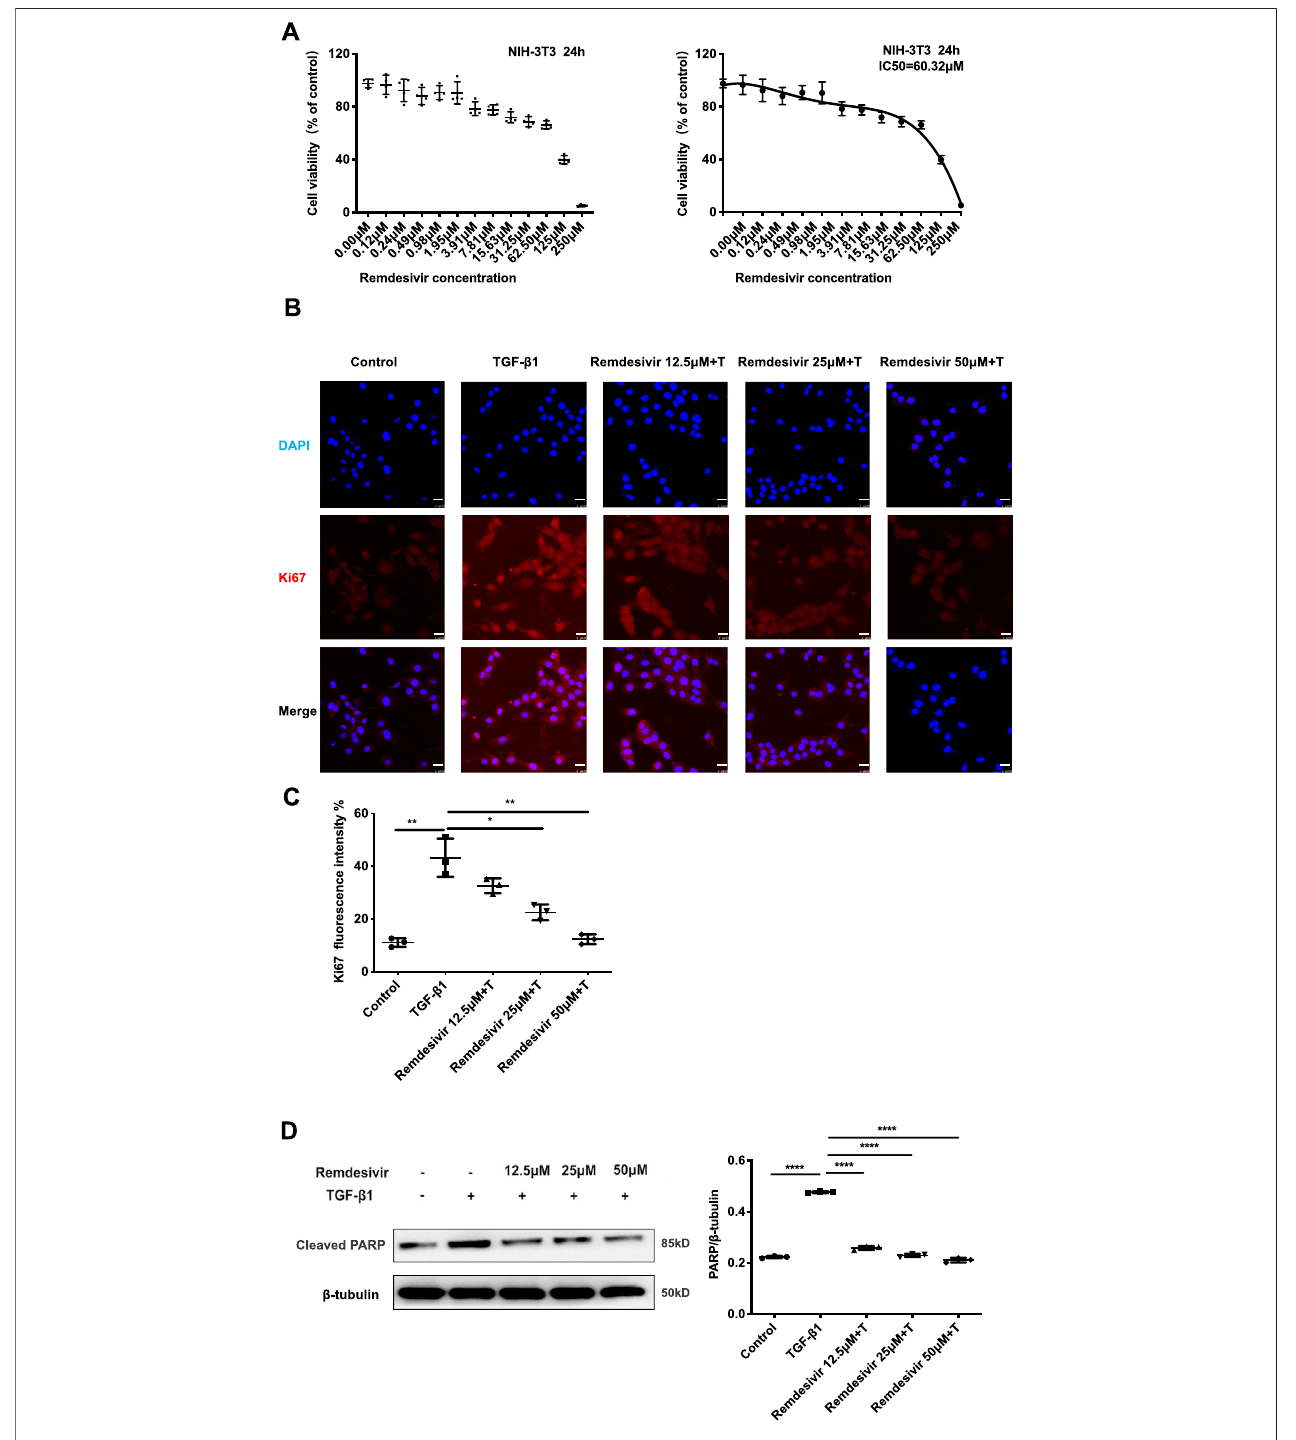
FIGURE 3 | Remdesivir suppresses TGF- β 1-induced proliferation of lung fi broblasts. (A) MTT assays of NIH-3T3 cells. Cells were exposed to the indicated doses ofRemdesivir(0 – 250 μ M)for24 h,IC 50 (cid:1) 60.32 μ M(n (cid:1) 4pergroup). (B – C) NIH-3T3cellswereco-treatedwithTGF- β 1(5 ng ml − 1 )andRemdesivir(12.5,25,50 μ M)for 24 htodetecttheKi67expressionlevelsbyimmuno fl uorescence.Theanalysesofmeangrayvaluewereshownbelow.Scalebar (cid:1) 60 μ m(n (cid:1) 3pergroup). (D) NIH-3T3 cells were co-treated with TGF- β 1 (5 ng ml − 1 ) and Remdesivir (12.5, 25, 50 μ M) for 24 h. Cleaved PARP were assessed using western blot. GAPDH was used as the internal control, n (cid:1) 3. Data was presented as the means ± SD. * p < 0.05, ** p < 0.01, *** p < 0.001, **** p < 0.0001.